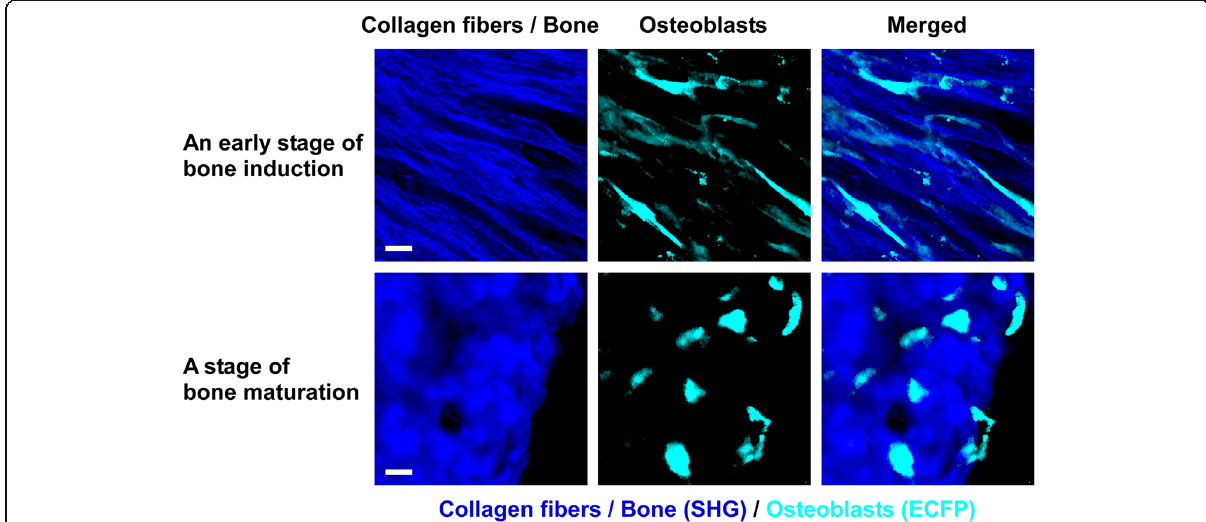
Fig. 5 Visualization of osteoblasts and collagen fibers (bone) during the bone induction process. At an early stage of bone induction, the morphology of osteoblasts shows spindle shape and collagen fibers are arranged in a specific (anisotropic) direction (upper panels). As the bone matures, the appearance of collagen fibers becomes isotropic. The osteoblasts spread across the surface of the induced bone, and the morphology of osteoblasts changes into a round or cuboidal shape [15]. Cyan, osteoblasts expressing Col2.3-ECFP; blue, bone tissues (second harmonic generation, SHG). Scale bar, 20 μ